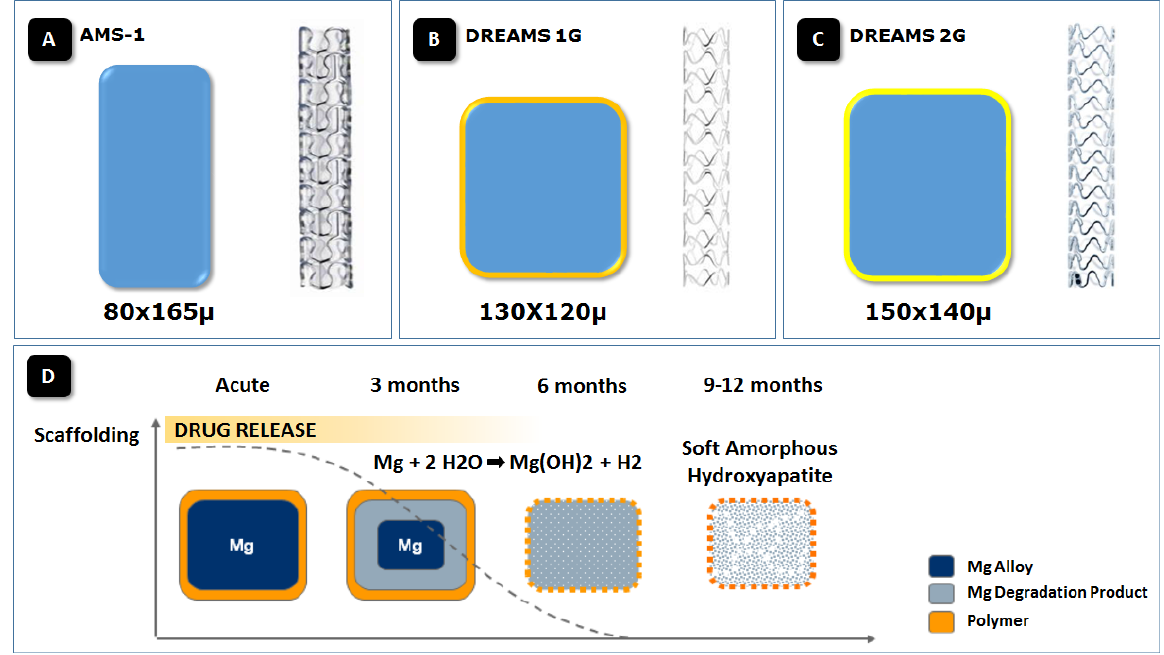
Figure 1. ( A ) Schematic cross-sectional profile of magnesium scaffolds struts of ( A ) uncoated, non-eluting, AMS-1 with 80 × 165 µ; ( B ) DREAMS 1st Generation (DREAMS 1G) with 130 × 120 µ struts and ( C ) DREAMS 2nd generation (2G) with 150 × 140 µ struts. The poly(lactide-co-glycolide)-coating with paclitaxel elution of the DREAMS 1G scaffold is indicated by the thin light orange layer. The PLA-coating with sirolimus elution of the DREAMS 2G scaffold is indicated by the thin dark orange layer; and ( D ) Schematic representation of the resorption process in the drug-eluting absorbable magnesium